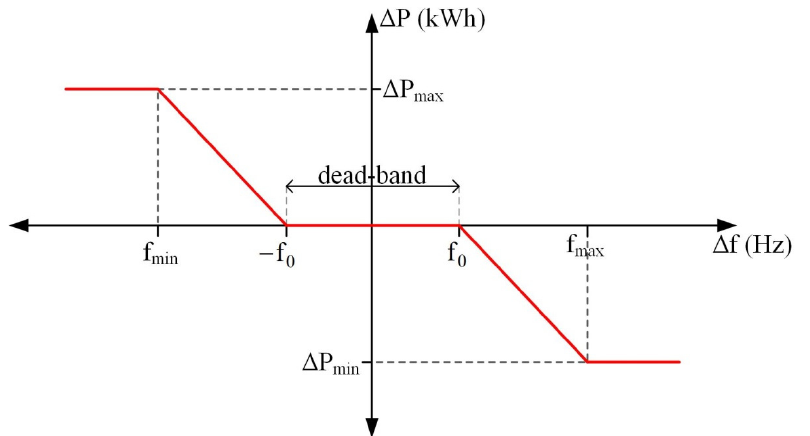
Figure 2. Droop frequency control scheme .